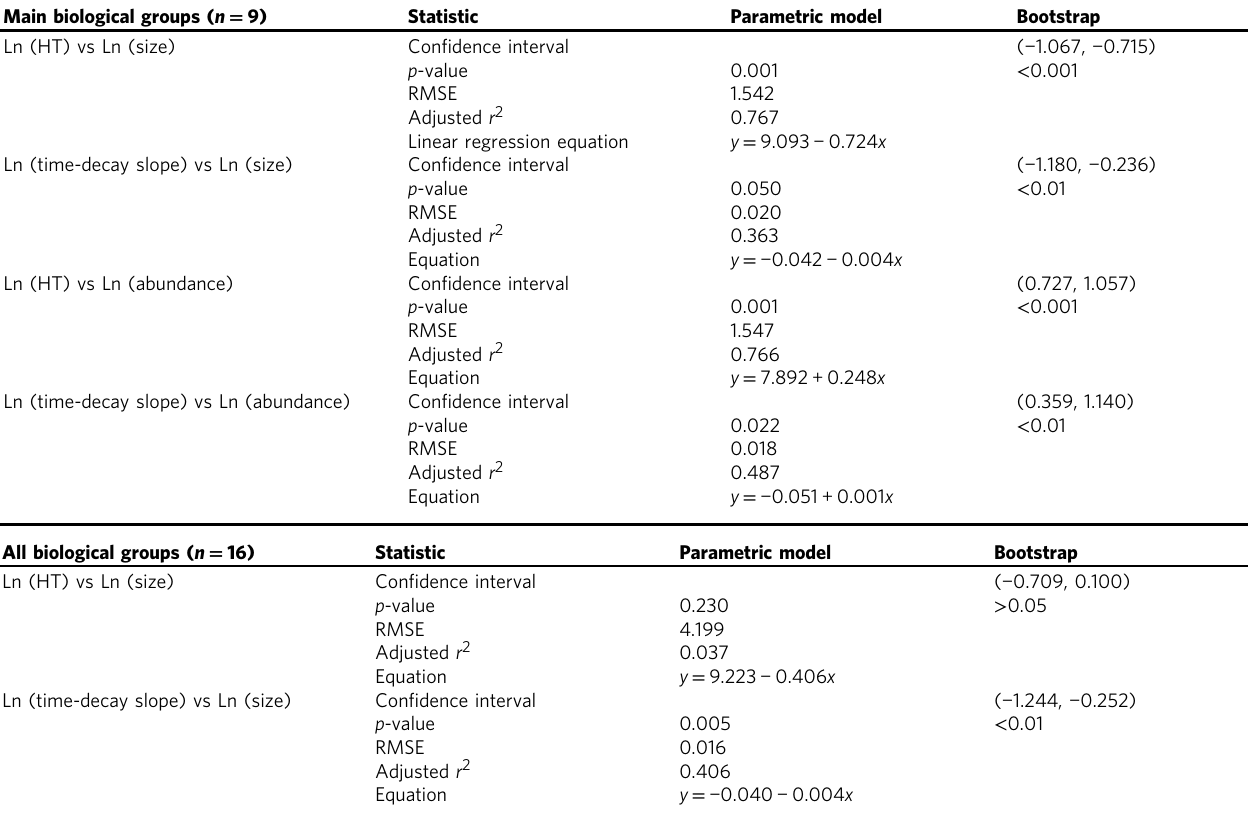
Table 4 Correlations between halving-time and time-decay slope with body size and local abundance Main biological groups ( n =